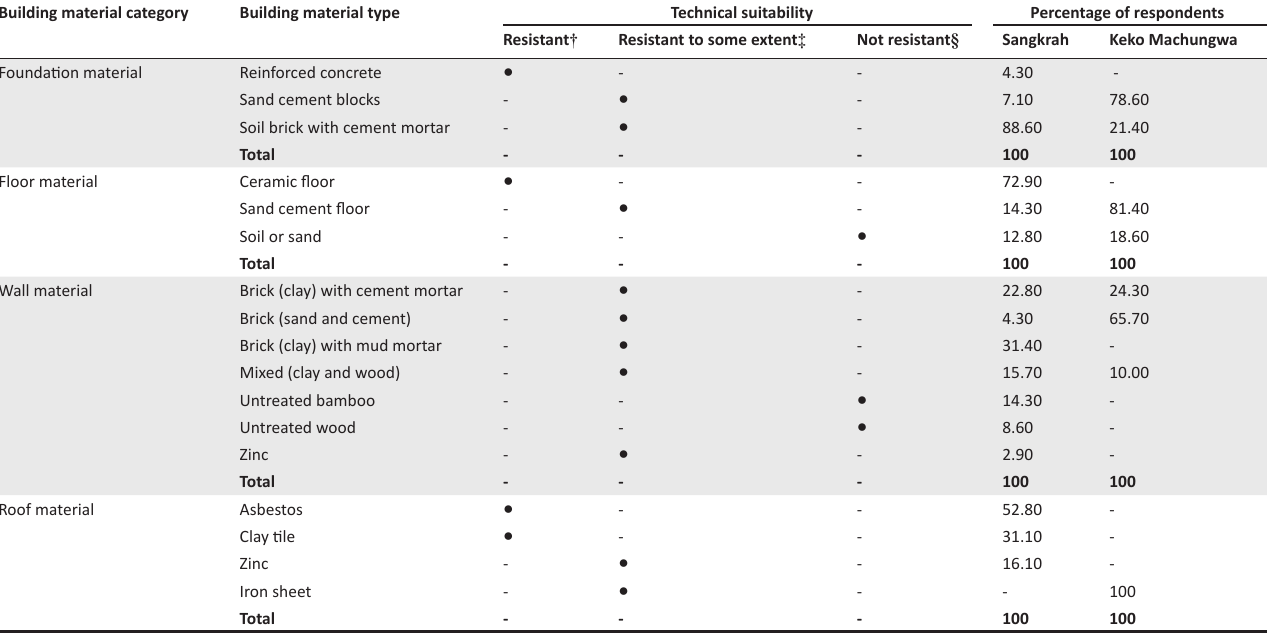
TABLE 1: Assessment of building materials in relation to flood resistance. Building material